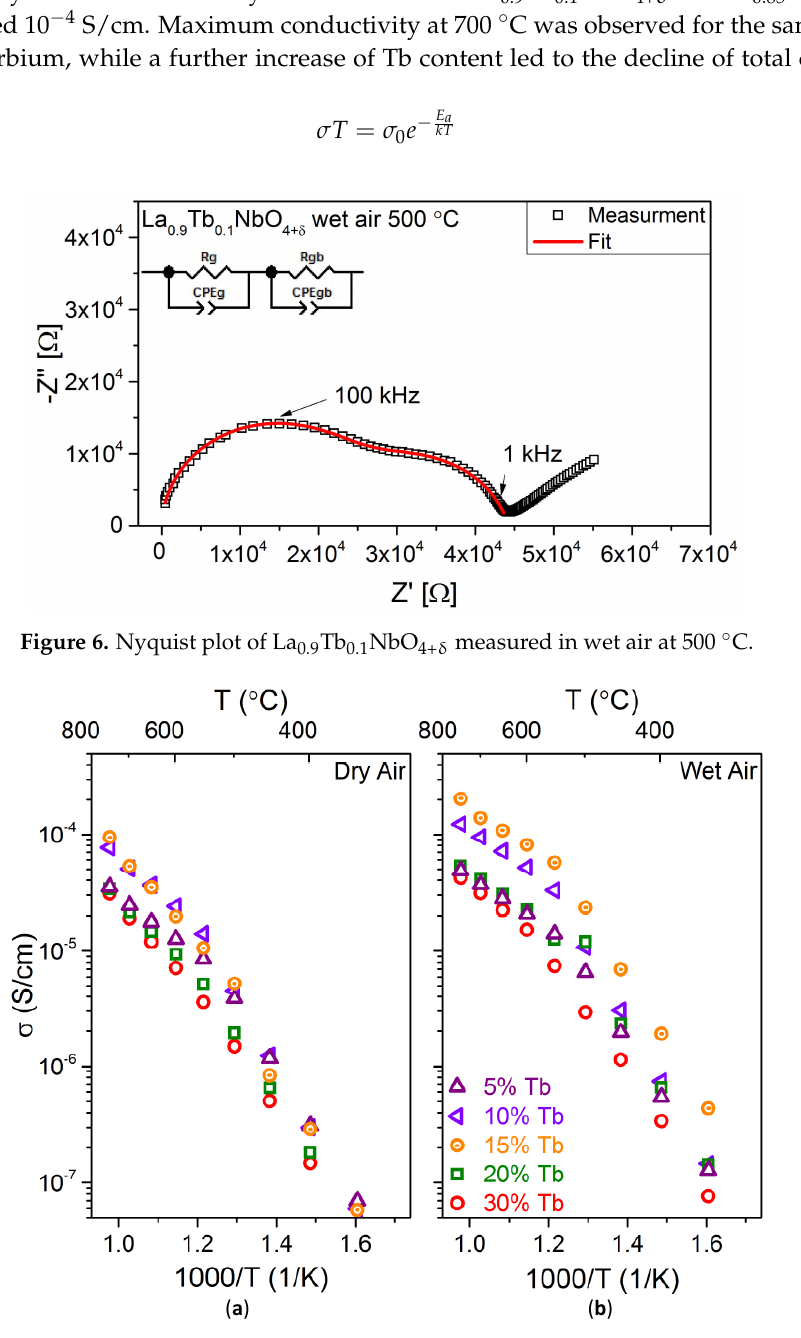
Figure 7. Total conductivity as a function of the reciprocal temperature of La 1 − x Tb x NbO 4+ δ in ( a ) dry air and ( b ) wet